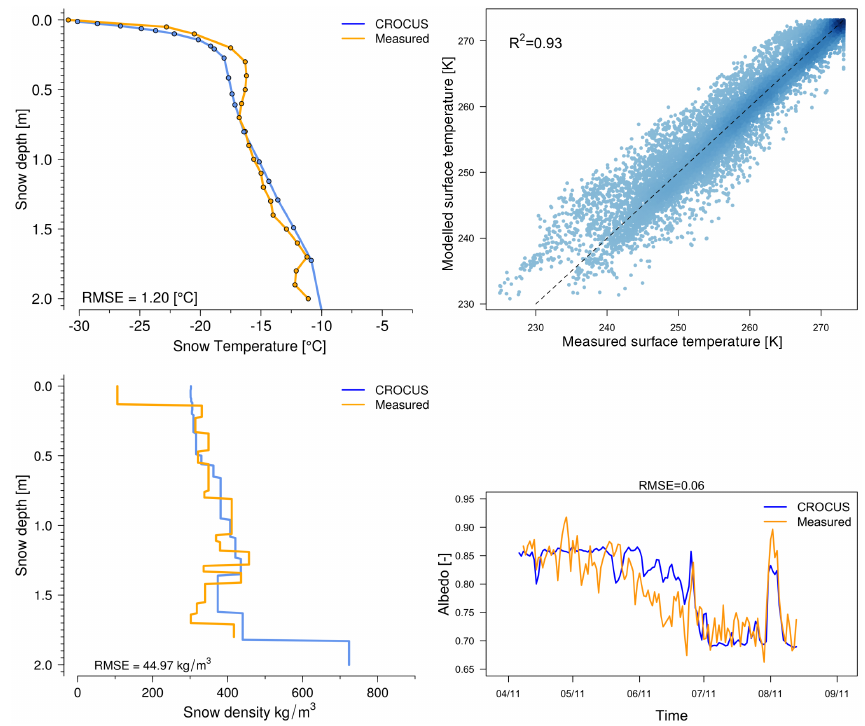
Figure 2. Comparison of the modelled and measured snow temperatures (upper left), snow density (lower left), snow surface temperature (upper right), and snow albedo (lower right) at the location